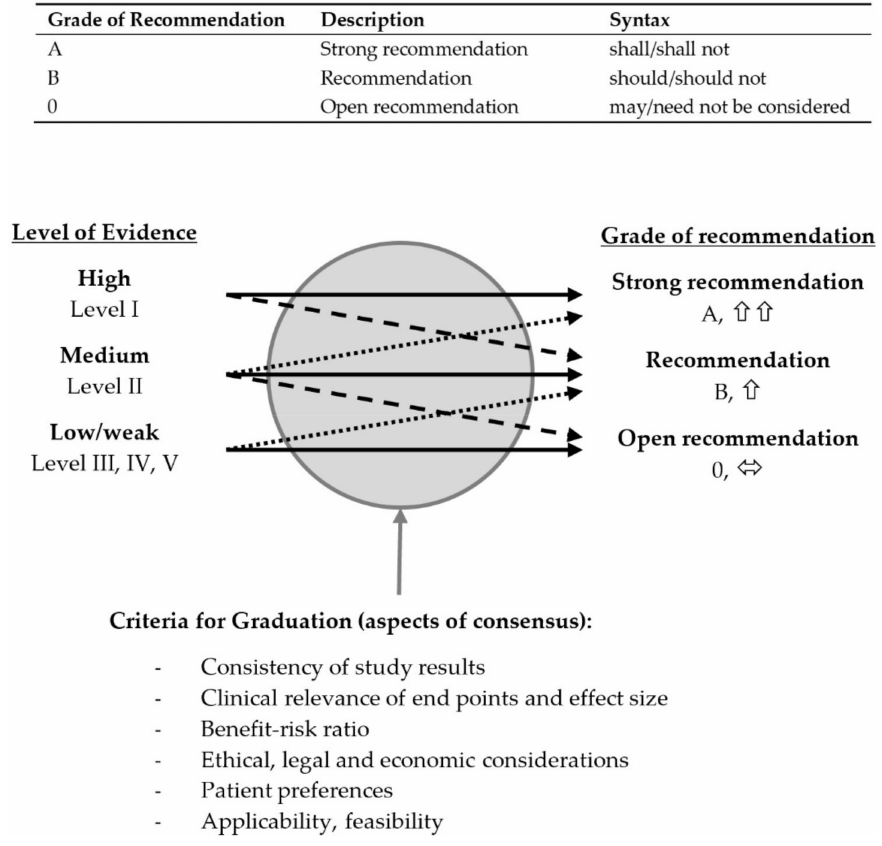
Figure 2. Classification of grades of recommendations according to AWMF rules and standards